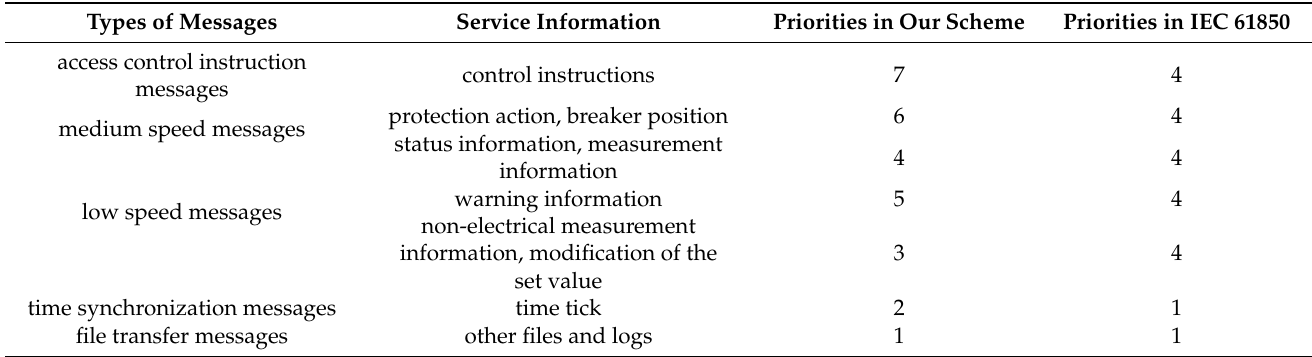
Table 3. The service priority scheme in this paper and the priority scheme in